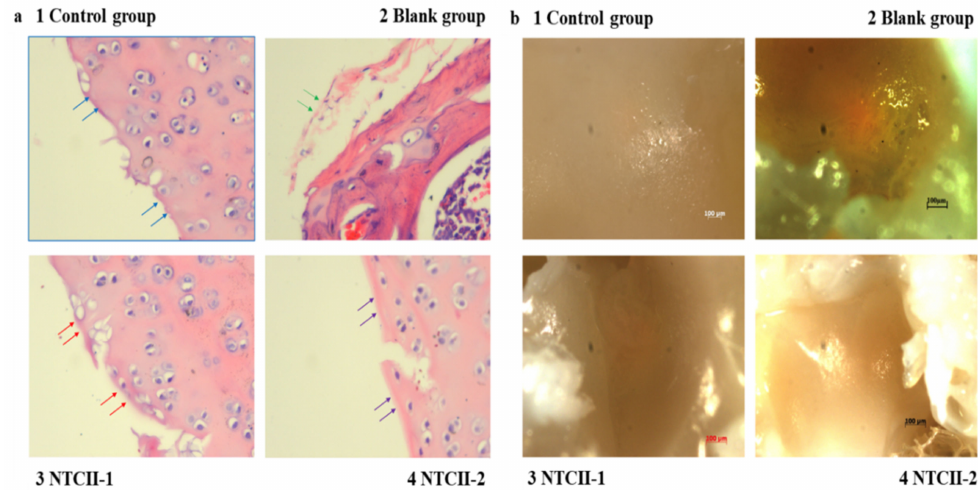
Figure 11. ( a ) The effect of collagen on the histopathology (HE staining) of the rat ankle joint tissues. ( b ) The high magnification stereo microscope of rat ankle surface. (Blue arrows show smooth surface with dense protein layer; green arrows show damage; red arrows show recovery; and purple arrows show fully recovered tissues. Control group: animals treated without any treatment, blank group: arthritis-induced animals were treated with 0.2 mL of 0.05 mol/L acetic acid solution for 4 weeks; NTCII-1 group: arthritis-induced animals were treated with 0.2 mL of 1 mg/mL NTCII solution for 4 weeks; and NTCII-2 group: arthritis-induced animals were treated with 0.2 mL of 3 mg/mL NTCII solution for 4